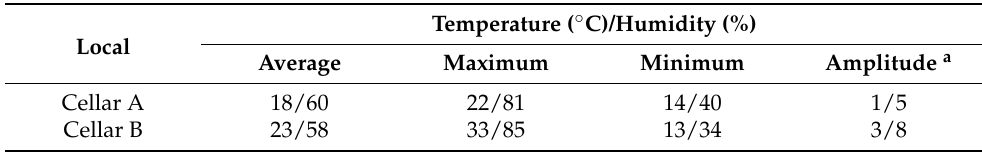
Table 1. Average, maximum, minimum and amplitude of temperature and humidity recorded in the Cellars A and B during the period under study (44